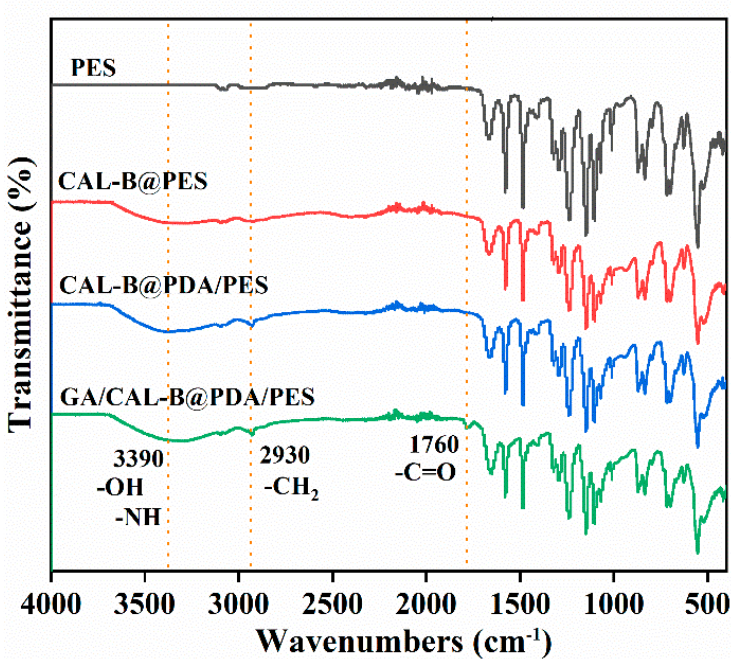
Figure 3. FTIR spectrum of BLIMs. Table 1. Elements analysis on the new membrane, CAL-B@PES, PDA/PES, CALB@PDA/PES